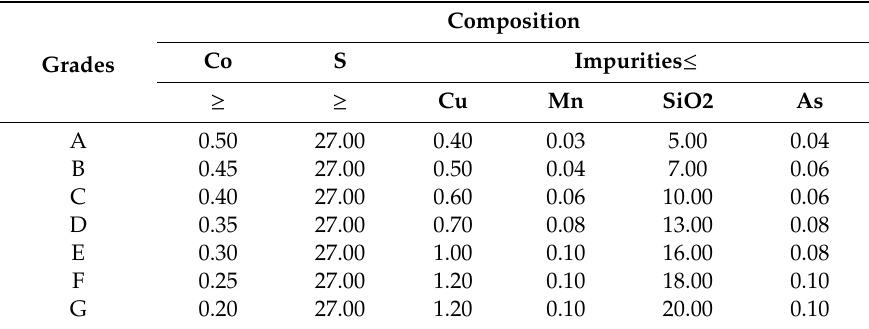
Table 4. Quality standard of cobalt–sulfur concentrate (%).